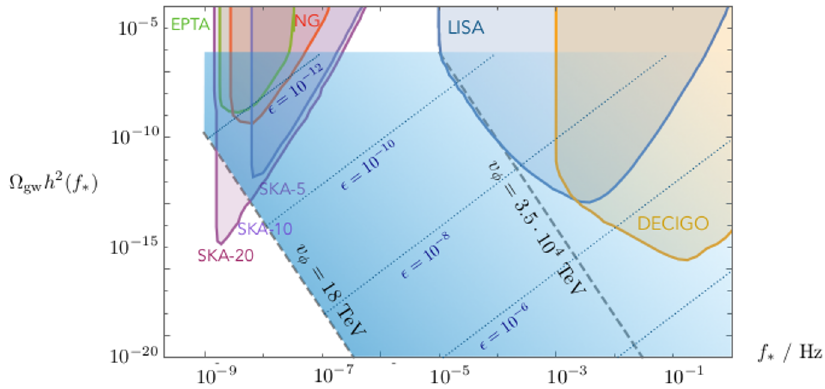
Figure 5 . In blue, region of parameter space where the frequency peak of the stochastic gravi- tational wave signal, f ∗ , as well as the corresponding energy density, Ω gw h 2 ( f ∗ ) , can fall in light of the experimental constraints on the various model parameters summarized in figure 4. Dot- ted lines correspond to constant (cid:15) . The region to the right of the dashed line corresponding to v φ = 3 . 5 · 10 4 TeV features a level of fine-tuning worse than 1 part in 10 10 , and it is therefore less attractive. Sensitivity curves for a variety of gravitational wave experiments are shown, including the pulsar timing arrays EPTA [92], NANOGrav [91], SKA [90] (observation time of 5, 10 and 20 years as indicated), as well as the space-based interferometers LISA [93], and DECIGO [94]. (For illustration, we have set the quartic coupling in the pseudo-scalar potential to be κ φ = 1 in this